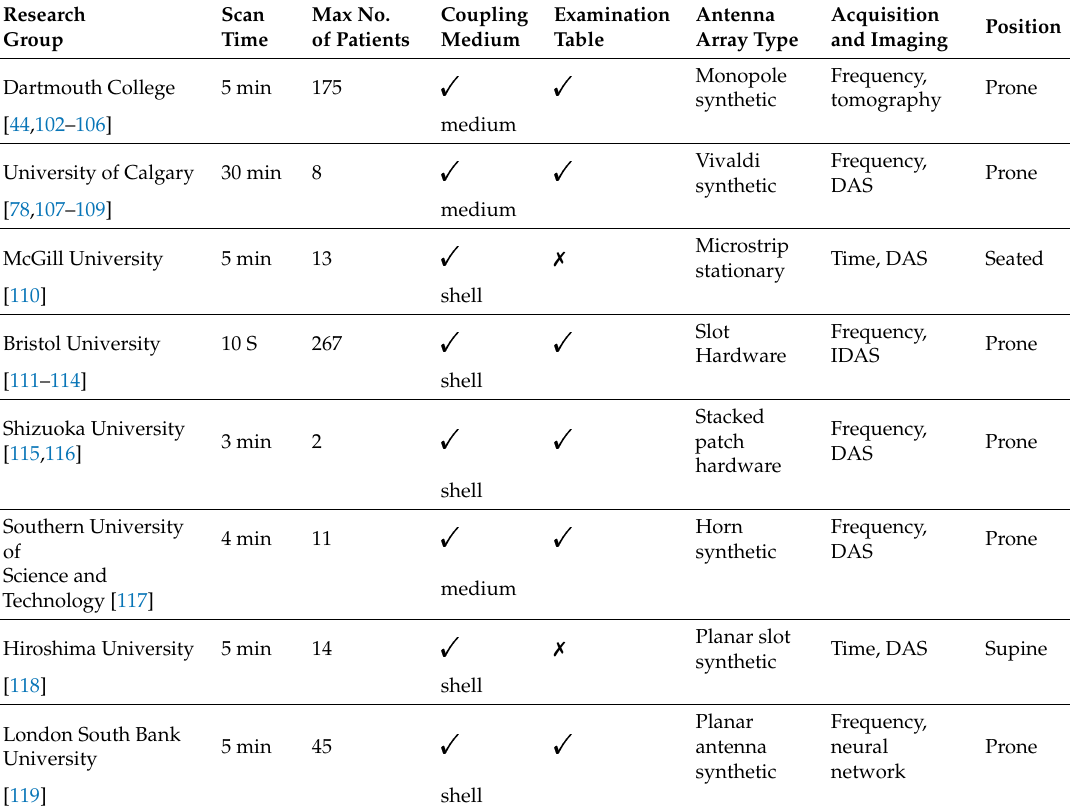
Table 3. Summary of some clinical MI